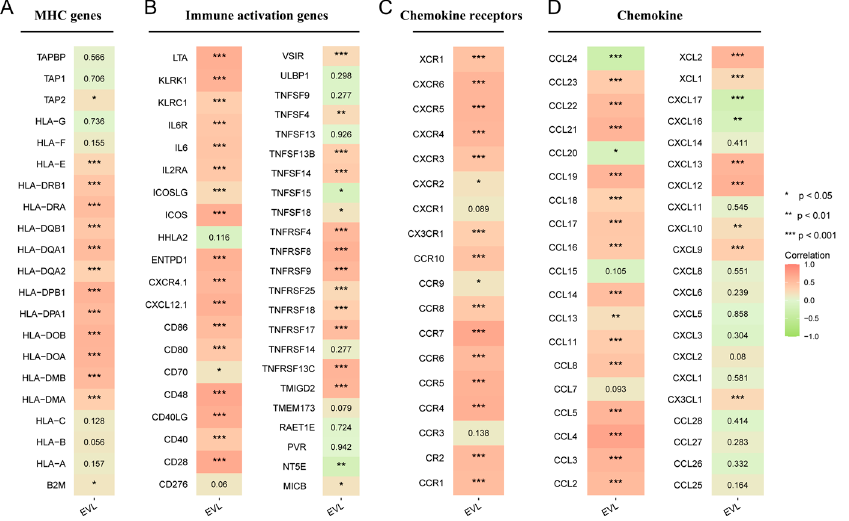
Figure 5. Correlation of EVL with immune-related gene sets. Correlation of EVL and MHC genes ( A ), immune activation genes ( B ), chemokine receptors ( C ) and chemokines ( D ). EVL, Ena-VASP-like. * p < 0.05; ** p < 0.01; *** p < 0.001.